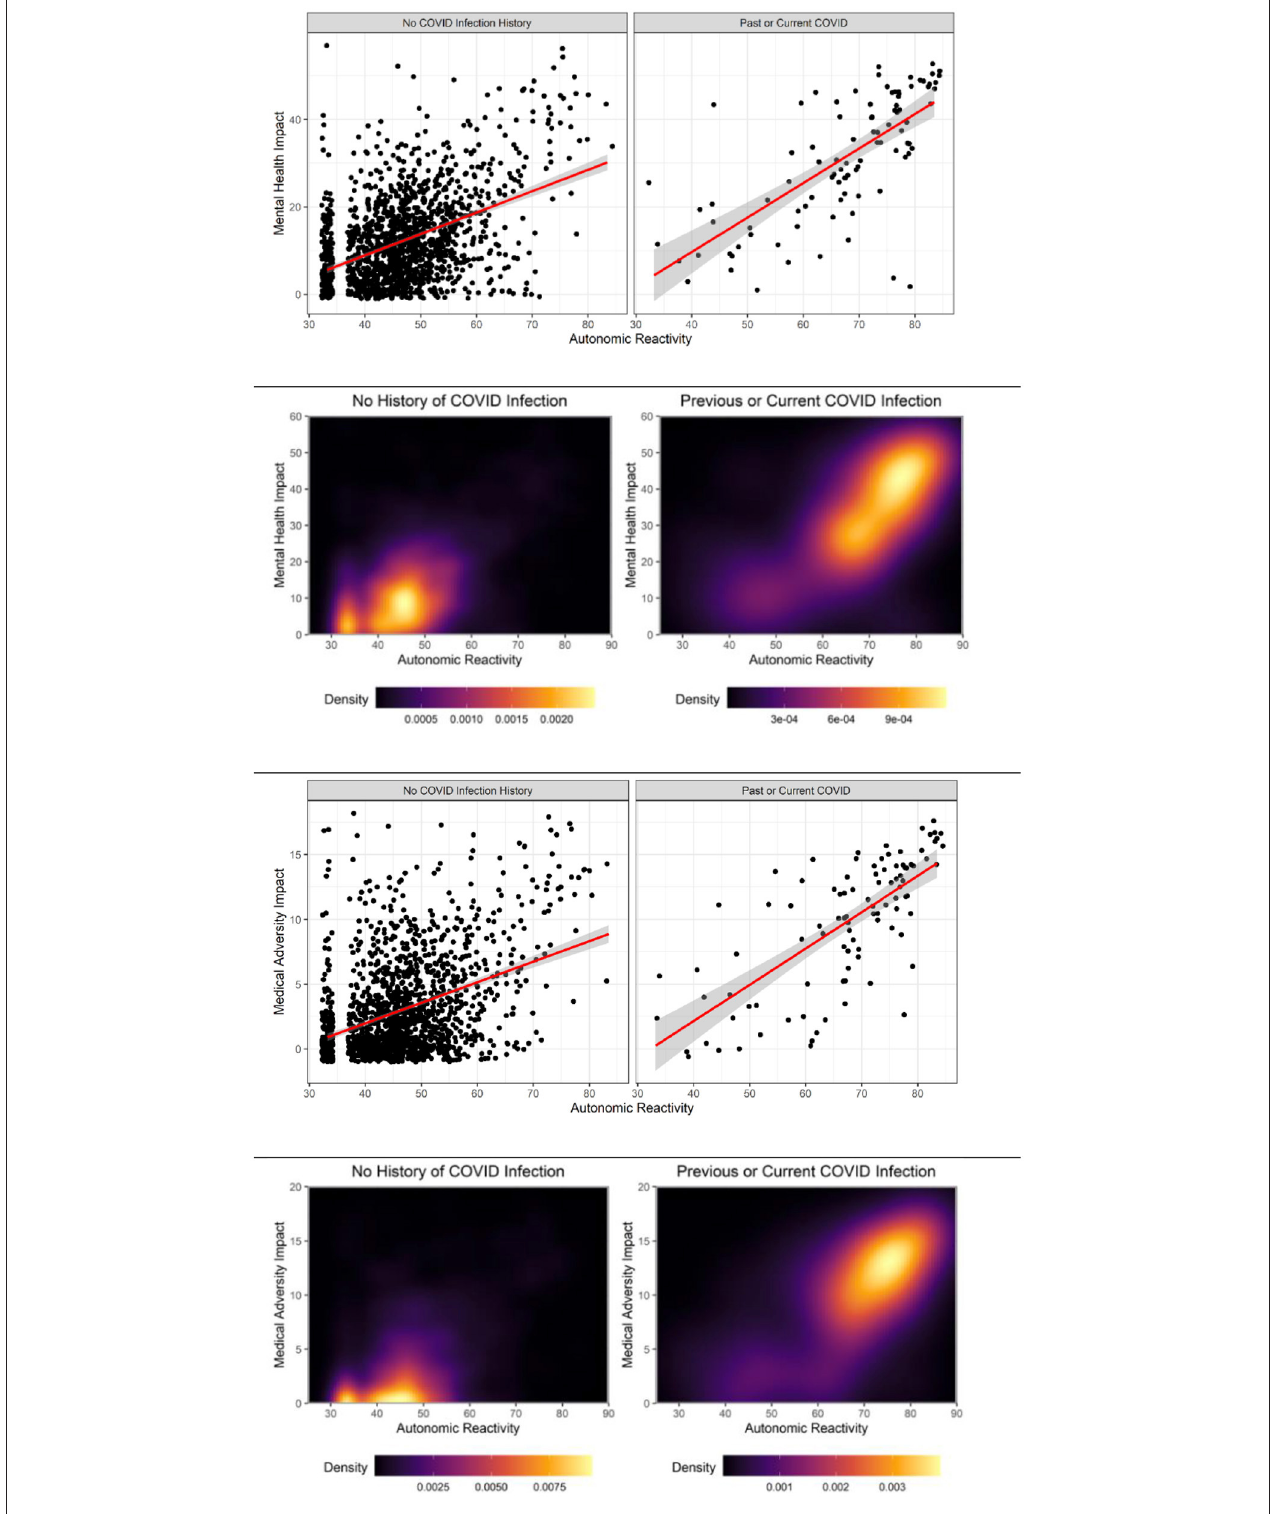
FIGURE 3 | COVID-19 diagnosis moderates relationship between adversity and autonomic reactivity.